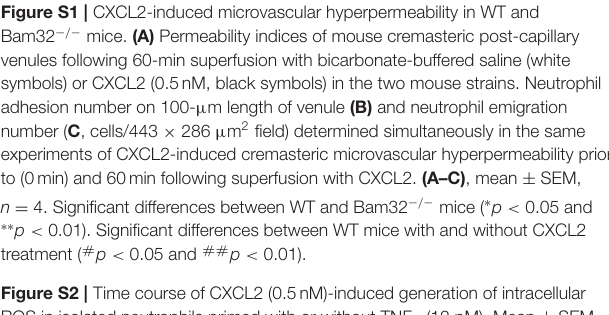
Figure S1 | CXCL2-induced microvascular hyperpermeability in WT and Bam32 − / − mice. (A) Permeability indices of mouse cremasteric post-capillary venules following 60-min superfusion with bicarbonate-buffered saline (white symbols) or CXCL2 (0.5nM, black symbols) in the two mouse strains. Neutrophil adhesion number on 100- µ m length of venule (B) and neutrophil emigration number ( C , cells/443 × 286 µ m 2 field) determined simultaneously in the same experiments of CXCL2-induced cremasteric microvascular hyperpermeability prior to (0min) and 60min following superfusion with CXCL2. (A–C) , mean ± SEM, n = 4. Significant differences between WT and Bam32 − / − mice ( ∗ p < 0.05 and ∗∗ p < 0.01). Significant differences between WT mice with and without CXCL2 treatment ( # p < 0.05 and ## p < 0.01). Figure S2 | Time course of CXCL2 (0.5nM)-induced generation of intracellular ROS in isolated neutrophils primed with or without TNF α (12 pM). Mean ± SEM, n = 4. Figure S3 | Effects of ERK1/2 inhibitor BVD-523 on intracellular ROS production in WT neutrophils treated with WKYMVm (0.1 µ M) or PMA (0.2 µ M). Mean ± SEM, n = 3–4. Significant differences between WKYMVm-stimulated groups with and without BVD-523 ( ∗ p < 0.05, ∗∗ p < 0.01 and ∗∗∗ p < 0.001). Significant differences between PMA-stimulated groups with and without BVD-523 ( ### p <